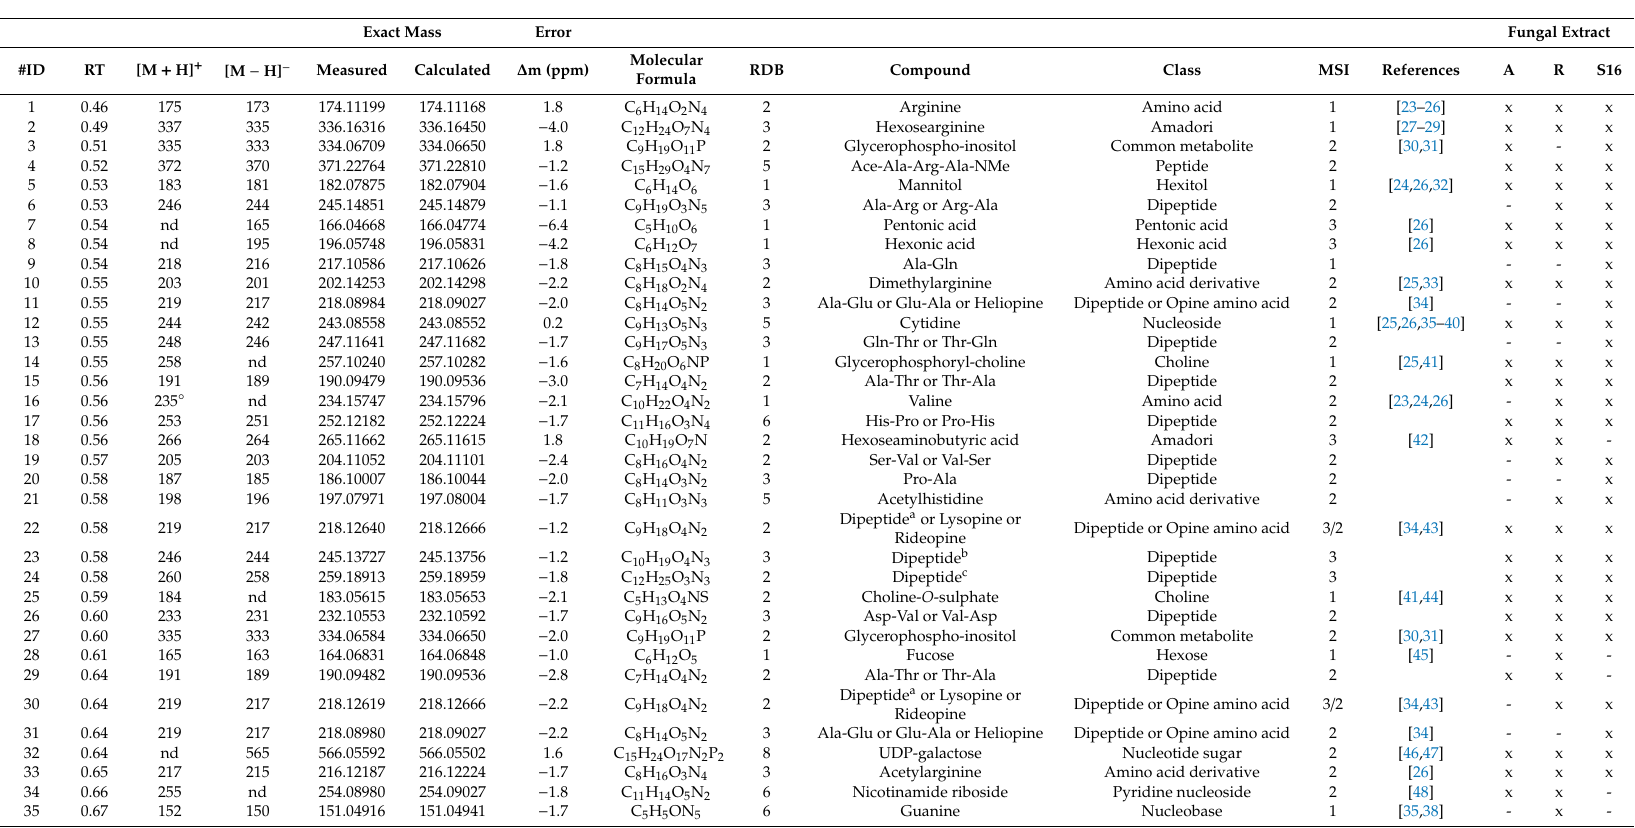
Table 2. The identified metabolites from the aqueous endophytic fungi extracts. Metabolomics Standards Initiative (MSI) was used to define the metabolite identification confidence [21,22]. Level 1 is for confidently identified compounds, where an authentic chemical standard was analyzed under same analysis conditions. Level 2 is for putatively annotated compounds, where physicochemical properties and spectral similarities with public spectral libraries as well as listed references were used. Level 3 is for putatively annotated compound classes, where characteristic physicochemical properties or spectral similarities of compound classes are used to confirm identity. Unidentified compounds are shown in the Supplementary Table S1 and their identification is level 4: unidentified and unclassified but can be di ff erentiated based upon spectral data. Listed references were used to confirm the identification for example by similar findings from natural sources and further justifications are described after the table. If the observed intensity of the metabolite in the total ion chromatogram is over 1 × 10 7 , metabolite is marked with x under the corresponding fungal extract. nd = not detected. RDB = ring-double bond